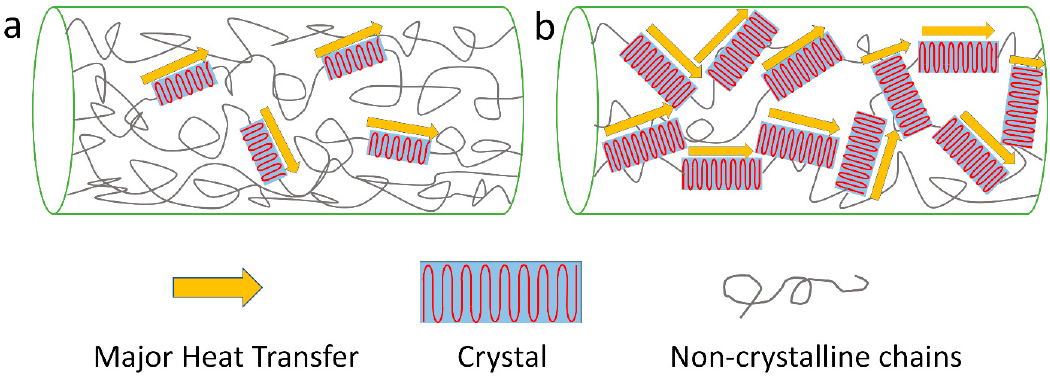
Figure 3. Effect of crystallinity on heat transfer: ( a ) structure of bulk polymer material with low crystallinity; ( b ) structures of polymer material with higher crystallinity.